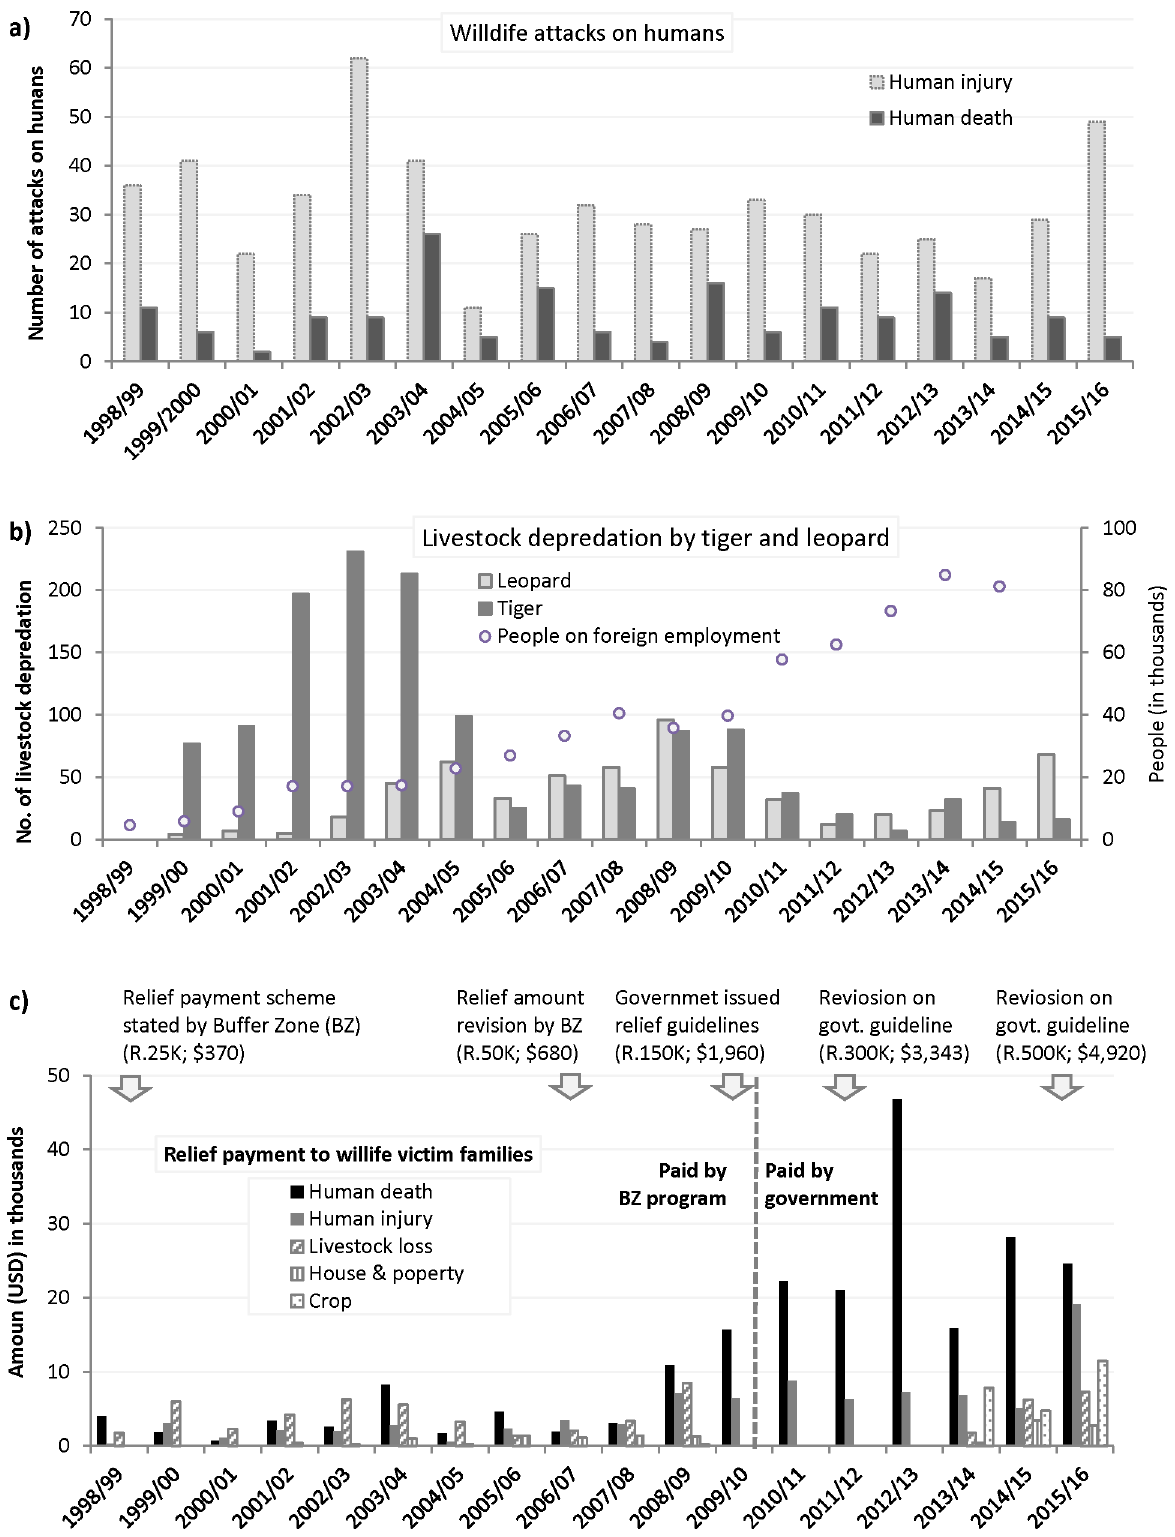
Fig 2. Wildlife attacks on humans, livestock depredation and relief payments over the years in Buffer Zone of Chitwan National Park, Nepal, a) Human death and injury b) livestock depredation caused by tiger and leopard, and its relation with people on foreign employment c) Amount of